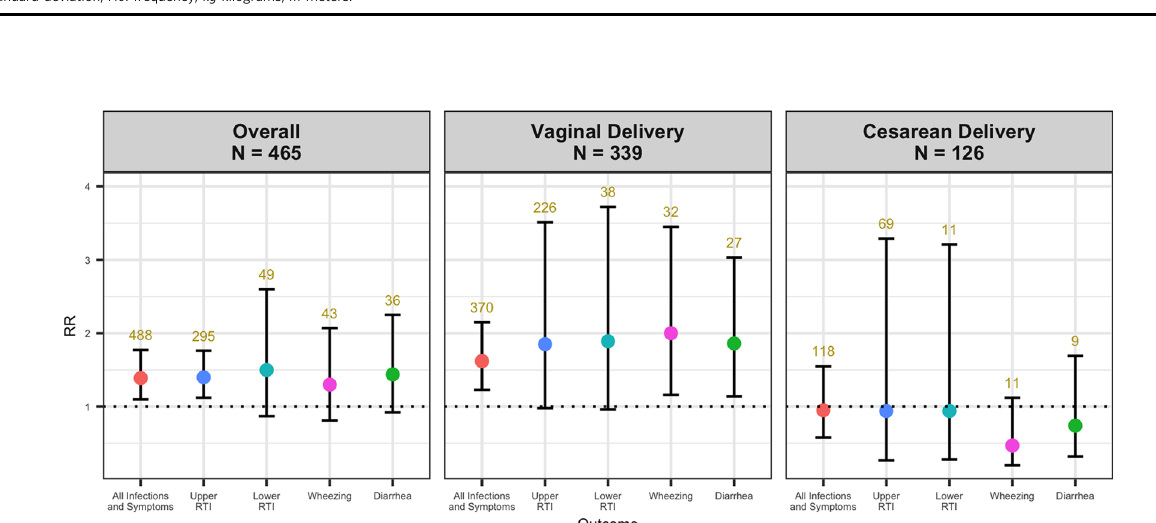
Fig. 1 Dot and Whisker plots of adjusted relative risk estimates and 95% con fi dence intervals from GEE analysis of 6-week-old infant stool 16S V4 – V5 rRNA sequencing alpha diversity and infections and symptoms of infection over the fi rst year of life. Overall GEE adjusted for maternal BMI, delivery type, sex, breast feeding at six weeks, perinatal antibiotic use, and gestational age. GEE strati fi ed by delivery mode (vaginal and cesarean) adjusted for maternal BMI, sex, breast feeding at six weeks, perinatal antibiotic use, and gestational age. Red, blue, turquoise, pink, and green points represent relative risk for all infections and symptoms, upper RTI, lower RTI, wheezing, and diarrhea outcomes respectively. Vertical lines above and below points represent upper and lower con fi dence bands. Relative risk estimates represent an increased risk of having an additional infection or symptom of infection or an increased risk of experiencing wheezing or diarrhea with each doubling of the inverse Simpson index. Upper RTI, lower RTI, and wheezing outcomes are those diagnosed by a physician for which a medication was prescribed. Diarrhea outcomes are those diagnosed by a physician for whom no medication was prescribed. Numbers above upper con fi dence bands indicate the total number of outcomes, which may be greater than N due to repeated measures. Sample sizes were N = 464 for overall and N = 125 for cesarean delivery for diarrhea analyses due to missing data. GEE generalized estimating equation, N sample size, RR relative risk, RTI respiratory tract infection.